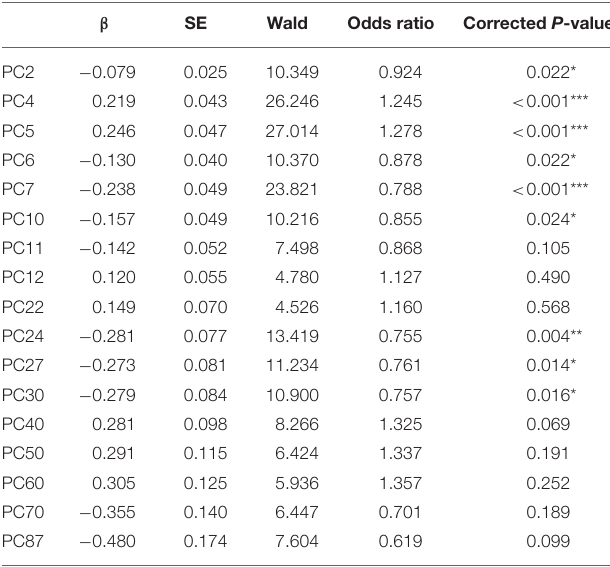
TABLE 3 | Binary logistic regression model of spatiotemporal features. β Wald Odds ratio Corrected P -value